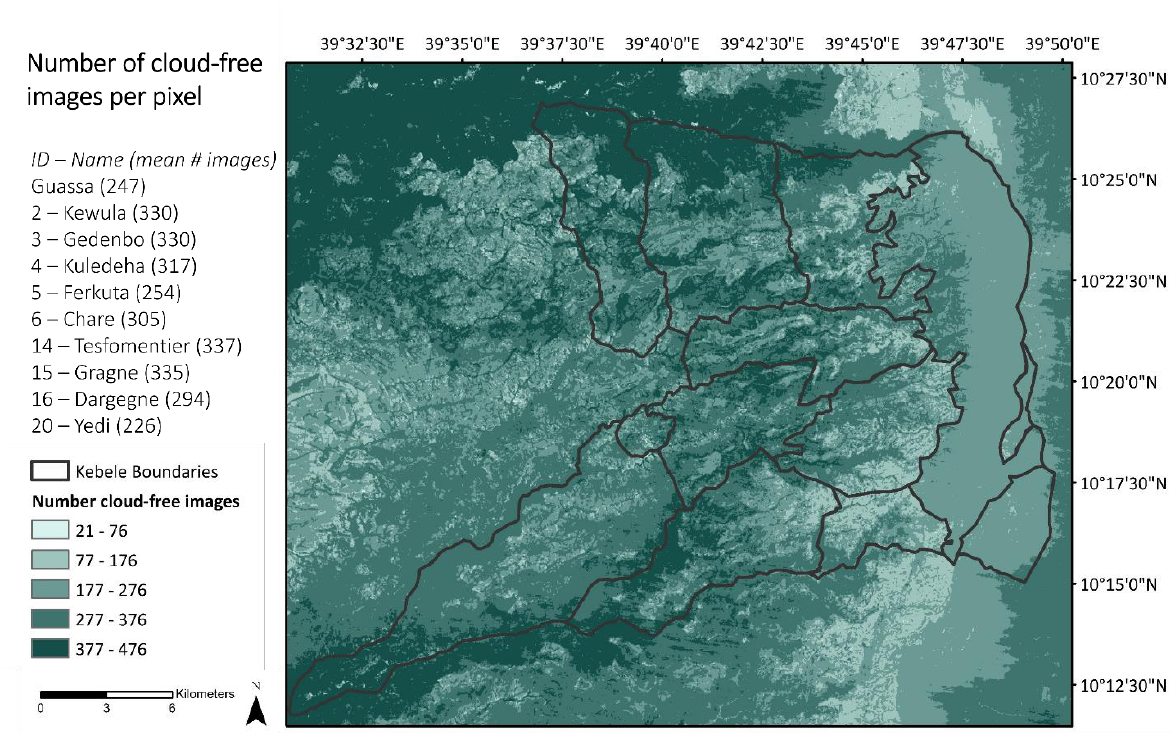
Fig. A1.3. The number of cloud-free images per pixel across the study